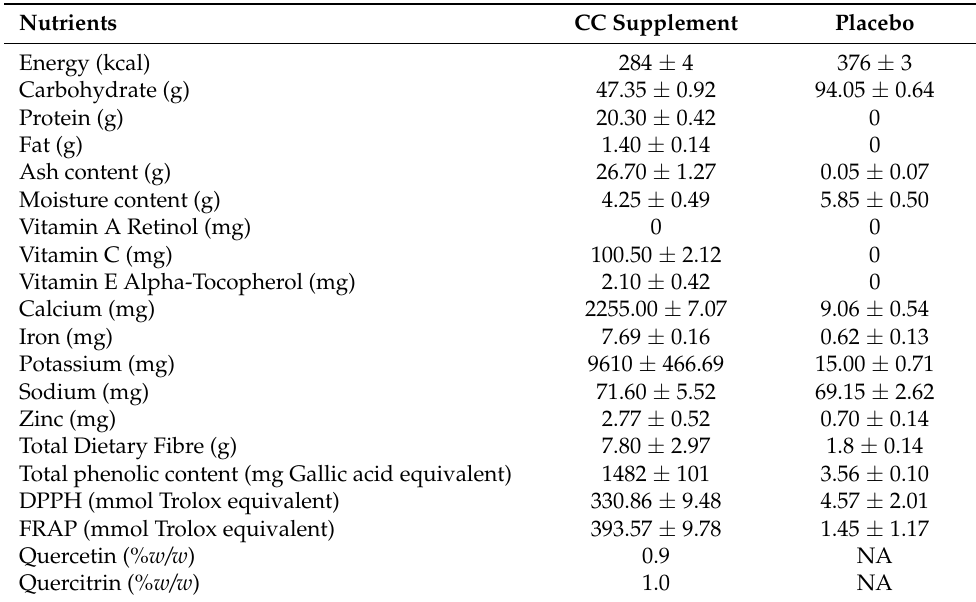
Table 1. Nutrient composition of Cosmos caudatus (CC) supplement and placebo (per 100 g). Nutrients CC